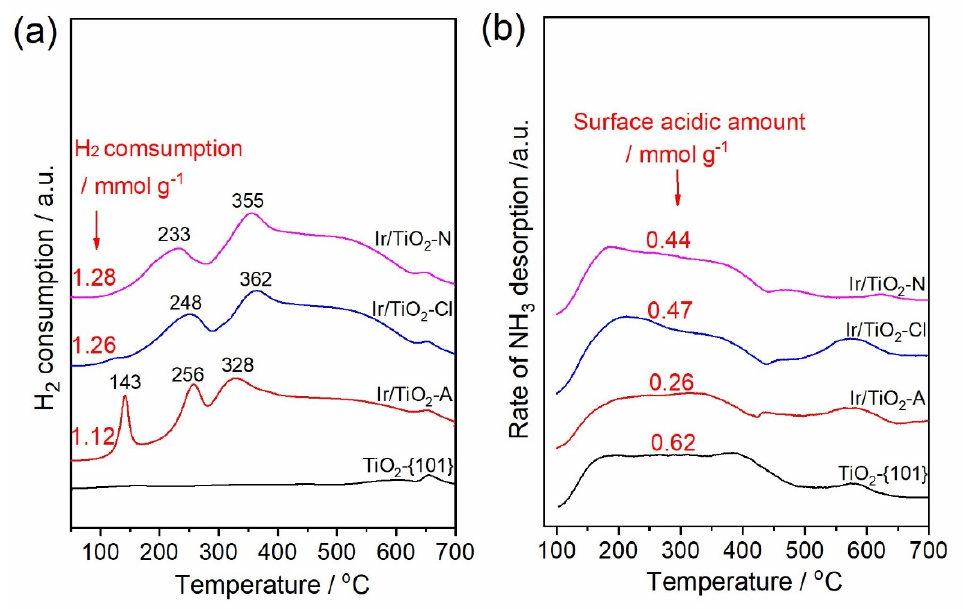
Figure 3. ( a ) H 2 -TPR and ( b ) NH 3 -TPD profiles of pre-reduced bare TiO 2 -{101} NCs and Ir/TiO 2 catalysts.